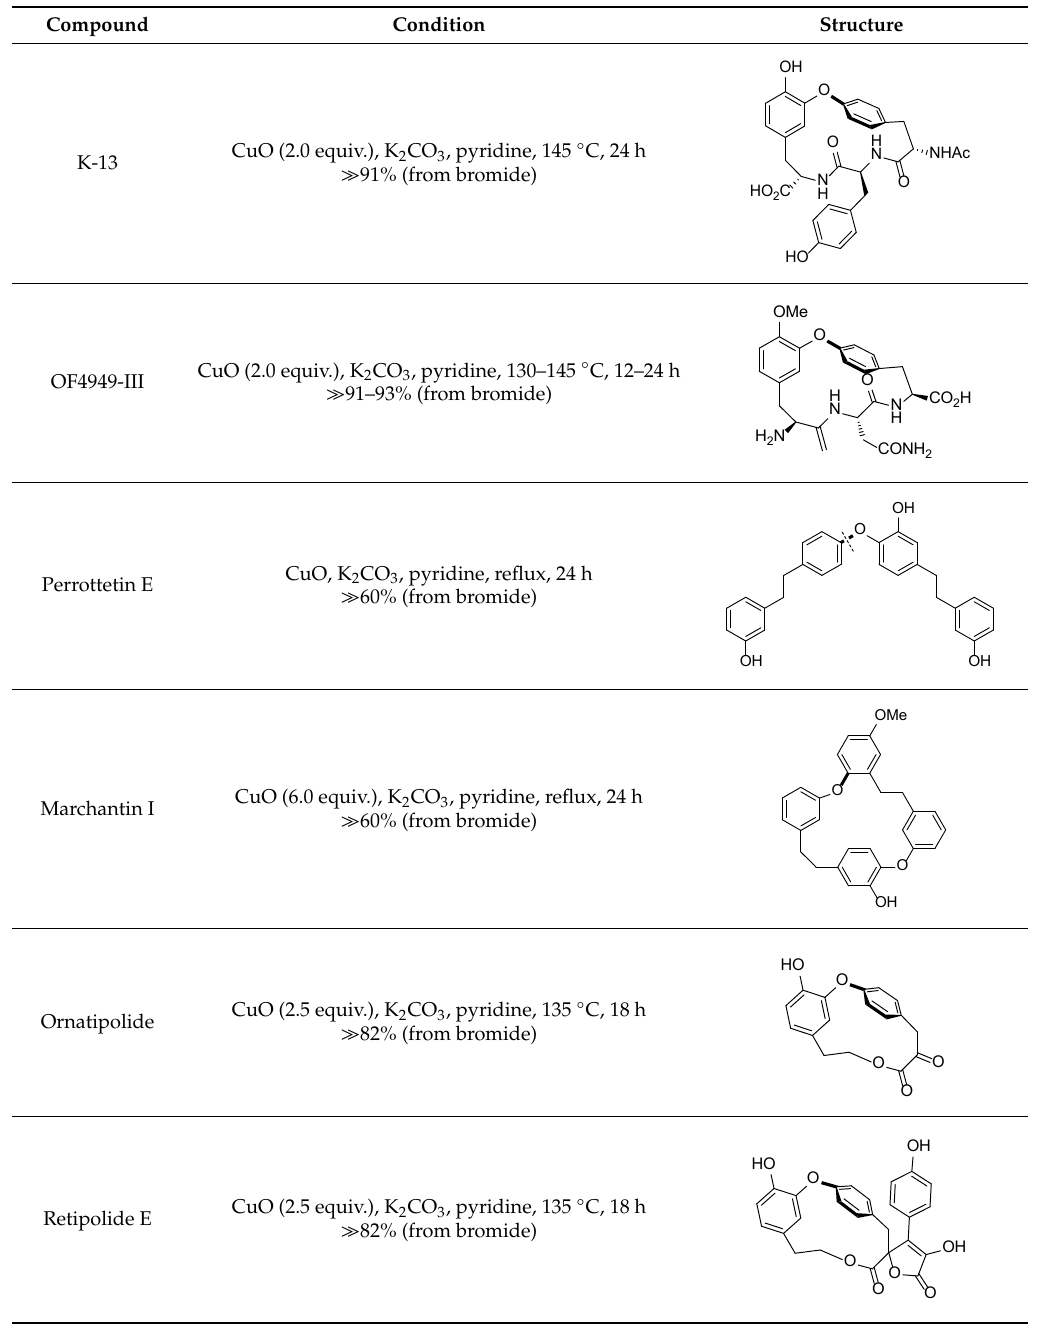
Table 10. The representative example of a natural product using modified methods in cyclic isodityrosine natural products.